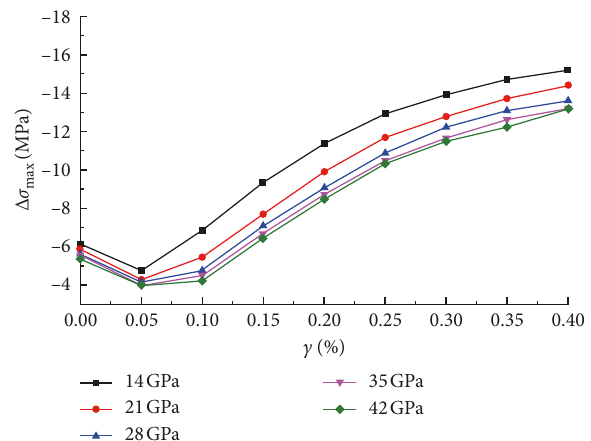
Figure 8: Relation between maximum stress deviation end-surface nonparallelism c